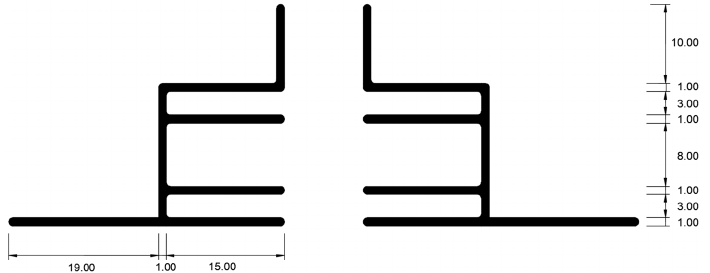
Figure 16. The designed Aluminium Extrusion (Alloy 6066, T5) for the Sliding Rigid Plastic Extrusion